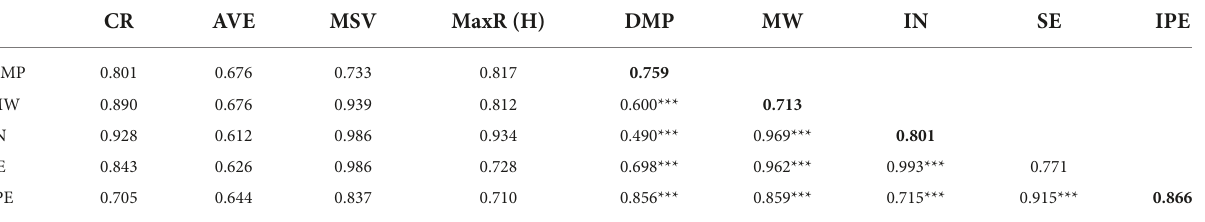
TABLE 2 Validity